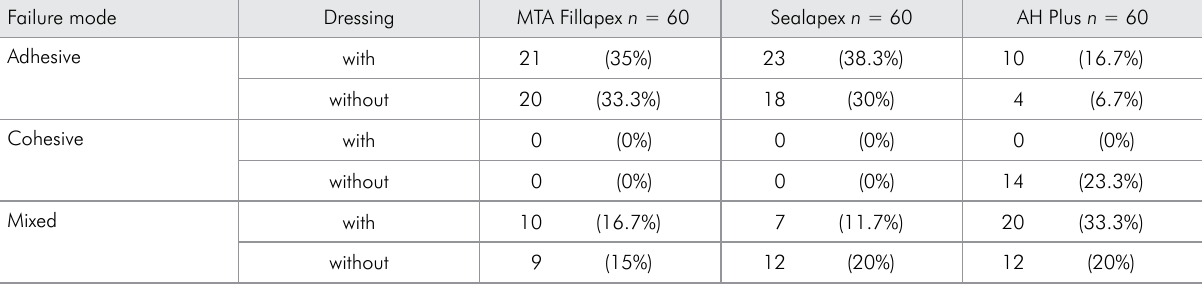
Figure 1. Representative image of adhesive table 3. Incidence and frequency (%) of each failure mode for each endodontic sealer, with or without prior application of calcium hydroxide dressing.